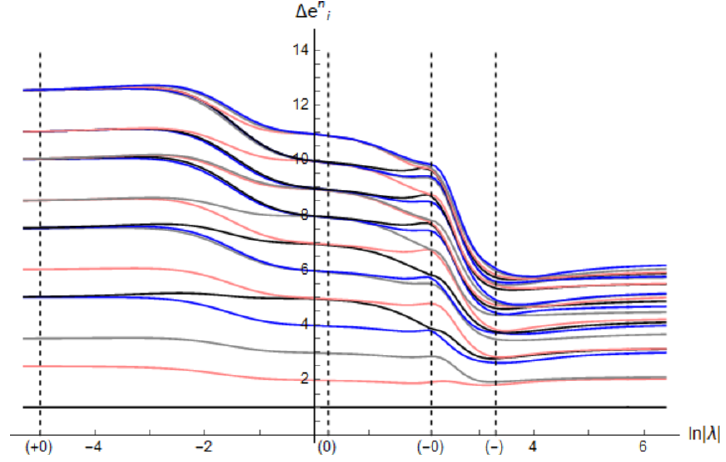
Figure 13. (cid:1) e i versus ln j (cid:21) j in the TIM with ( d )-spectator and (cid:21) < 0 with (cid:1) max =